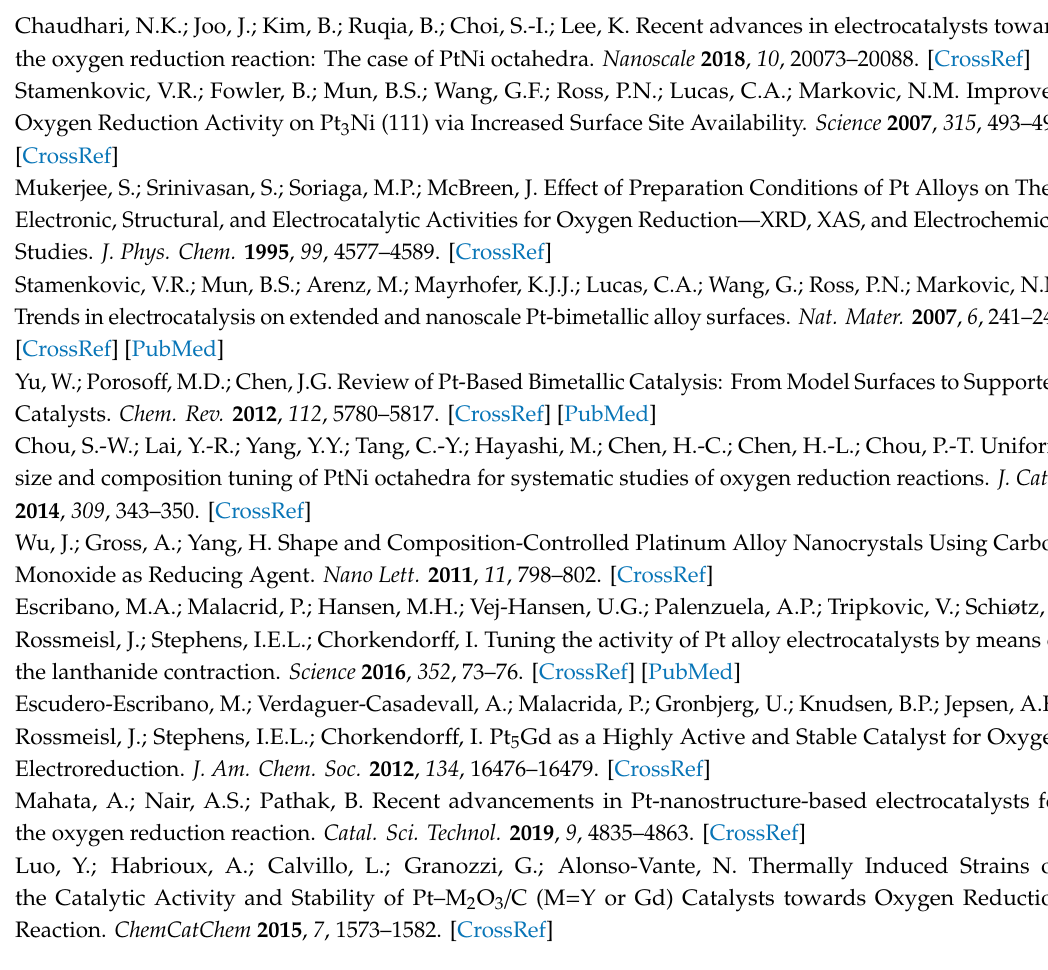
(3) , Figure S8: The N 1s spectrum of sample Pt / 4 fitted with two and three peaks, Figure S9: The N 1s spectrum of sample 4 fitted with three (1) and four (2) peaks, Figure S10: Photoelectron Pt 4f spectrum of sample Pt / 4, Figure S11: The C 1s photoelectron spectra of samples 1 (1) and Pt / 1 (2), Figure S12: The Ni 2p photoelectron spectra samples 1 (1), Pt / 1 (2) Ni foil (3) and sample Ni(OH) 2 (4), Figure S13: The Pt 4f photoelectron spectrum of sample Pt / 1, Figure S14: The C 1s photoelectron spectrum of sample 1 / Pt’, Figure S15: The photoelectron Gd 3d and Pt 4f spectra of sample Pt / 1 (cid:48) , Figure S16: The C 1s photoelectron spectrum of sample 2, Table S1: Binding energies (BE), Gaussian widths (GW) and relative intensities (I rel ) of some groups for the C 1s spectra of the samples